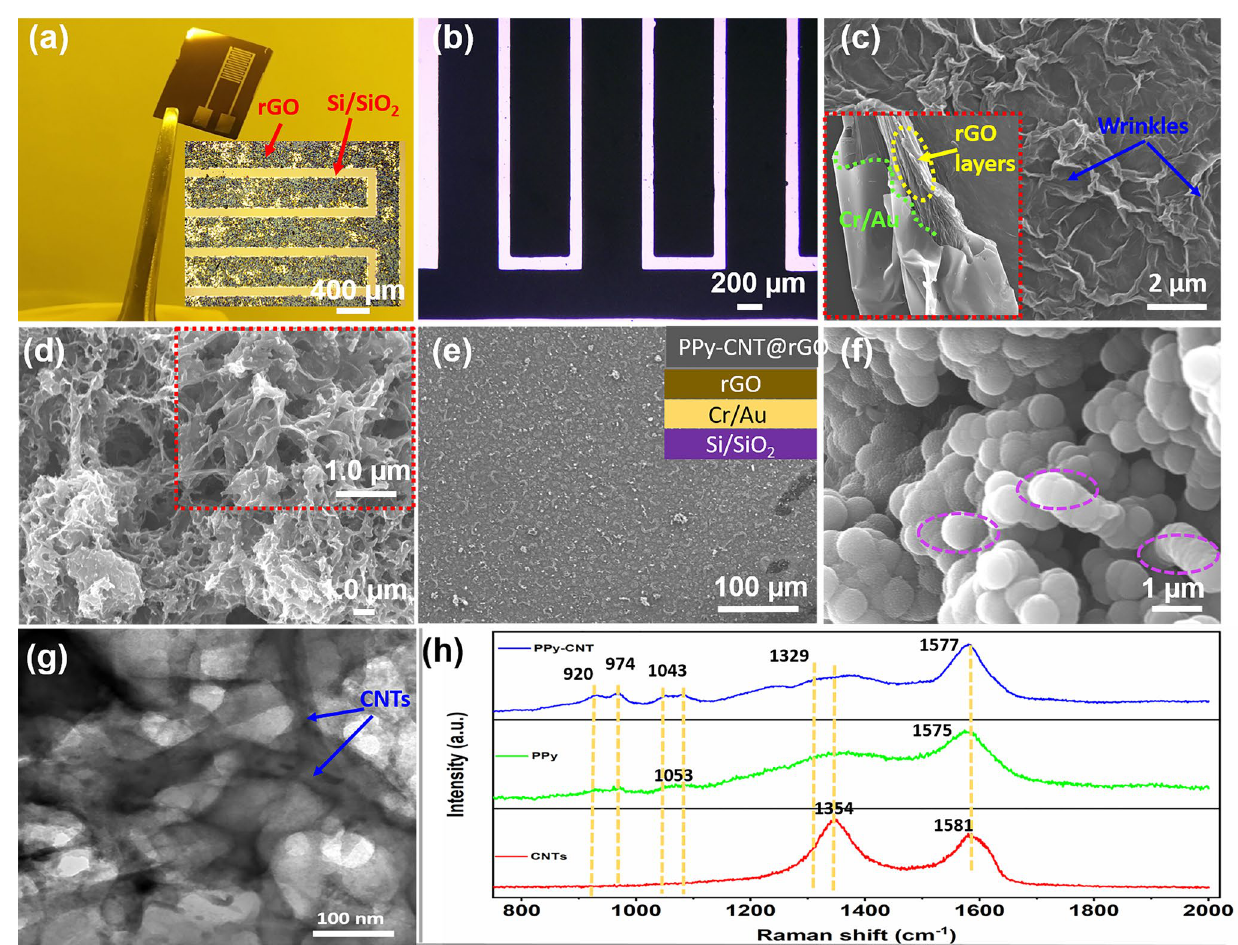
Fig. 2 Structural characterization results. a Photographic image of interdigital Cr/Au micropatterns, the inset shows the microscopic image of rGO@Au microelectrodes. b Optical image of PPy-CNT@rGO MSC. c SEM image of electrodeposited rGO on micropatterns. d SEM image of PPy-CNT on rGO by short-time deposition. e , f Low- and high-resolution SEM images of PPy-CNT composite electrochemically deposited on rGO@Au micropattern. g TEM image of PPy-CNT. h Raman spectra of CNTs, PPy and PPy-CNT